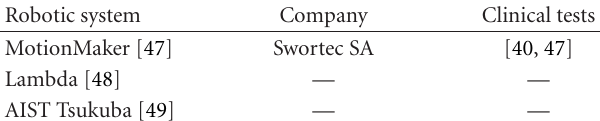
Table 5: Stationery robotic systems for ankle rehabilitation.